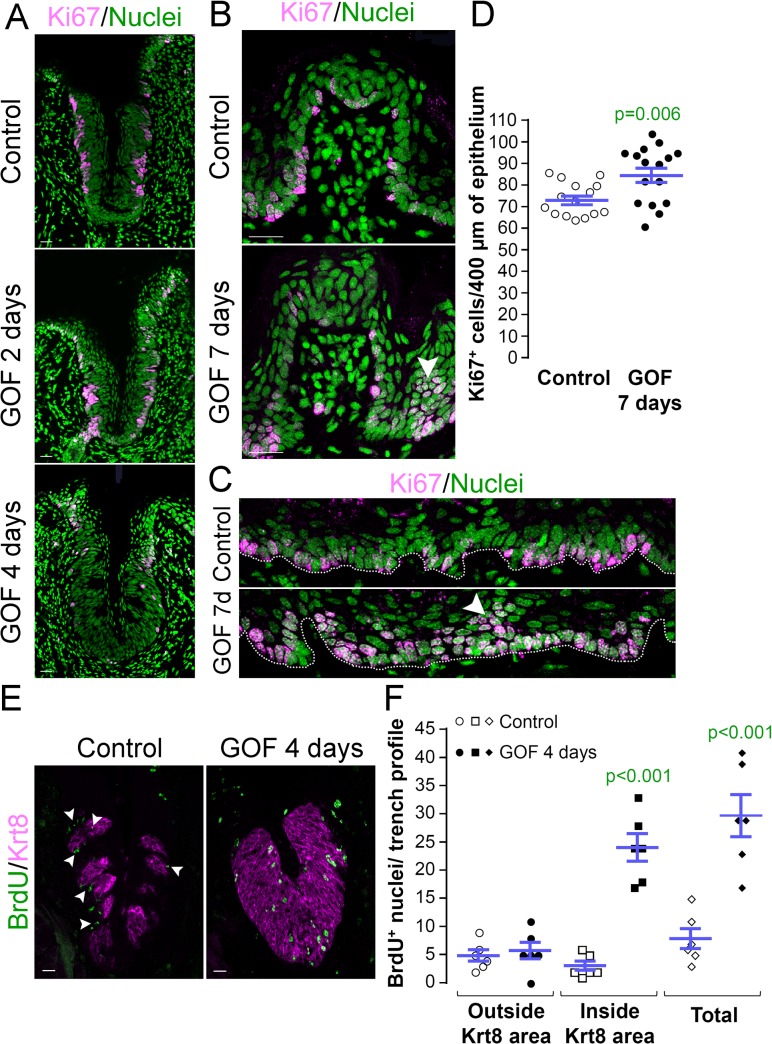
Stabilized β-catenin alters proliferation in anterior and posterior taste fields. A, GOF 2 days.After 2 days of dox, the proportion of Ki67+ basal keratinocytes in mutant CVP epithelium did not differ from controls (77.9 ± 2.3% vs. 76.2 ± 2.2% in controls vs. mutants; n = 3, p = 0.583, Student’s t-test). A, GOF 4 days. By day 4, proliferation in the mutant CVP was virtually abolished. B. In the FFP, the number of Ki67+ cells within the FFP epithelium are comparable in mutants and controls, but in mutants proliferation appears increased in epithelia at the FFP base (GOF 7 days vs control, white arrowheads). C. In controls, only cells in the basal layer of epithelium are Ki67+, while in mutants, multiple layers or clusters of cells were actively proliferating (GOF 7d, arrowhead). D. The number of Ki67+ basal cells per 400μm of epithelium is significantly increased in mutants. E,F. Mutant and control mice were injected with BrdU 48 hours before tongues were harvested after 4 days on dox chow. Postmitotic BrdU+ cells were detected in and around taste buds (Krt8+) in control CVP epithelium (white arrowheads), whereas β-catenin stabilization resulted in increased BrdU+ cells only within the expanded Krt8+ taste field. Nuclei were counterstained with Sytox Green. Stack images comprising 14 compressed 0.75 μm-thick optical sections are representative samples from 3 control and 3 mutant mice. Six CVP trenches and 15–16 sections of non-taste epithelium were analyzed per group. Data are represented as scatter plot (individual symbols), and mean ± SEM (blue bars). Student’s t-test. Dotted line delineates the basement membrane. Scale bars = 20 μm.